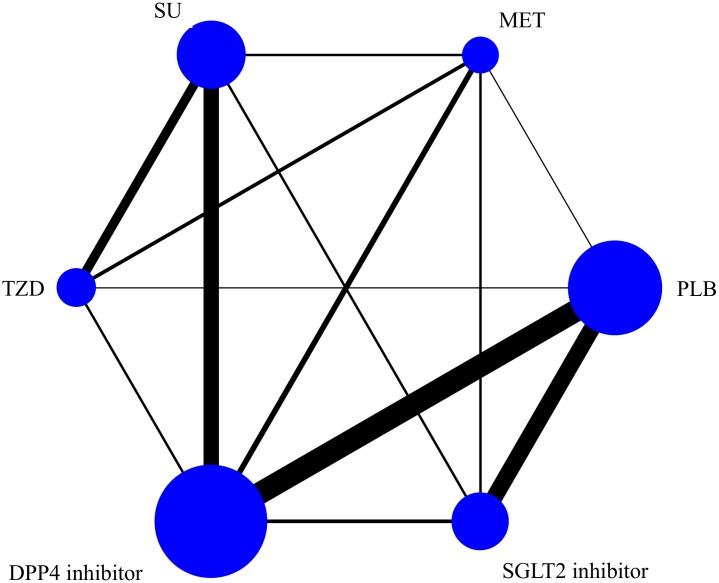
Network of oral antidiabetic drugs comparison of all-cause mortality for the network meta-analysis.Each circle node represents a drug included in the analysis and the size of circle is proportional to the number of patients randomly assigned to the drug. Each line corresponds to direct comparison between drugs and the width of line is proportional to the number of trials comparing each pair of treatments. TZD: thiazolidinedione. DPP4: dipeptidyl peptidase-4. SGLT2: sodium glucose cotransporter-2.